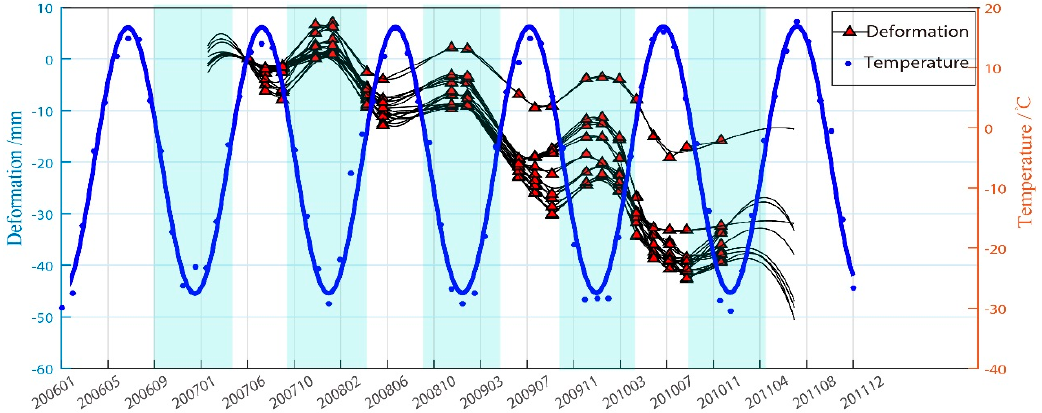
Figure 9. The deformation time-series for area P1 and the temperature.